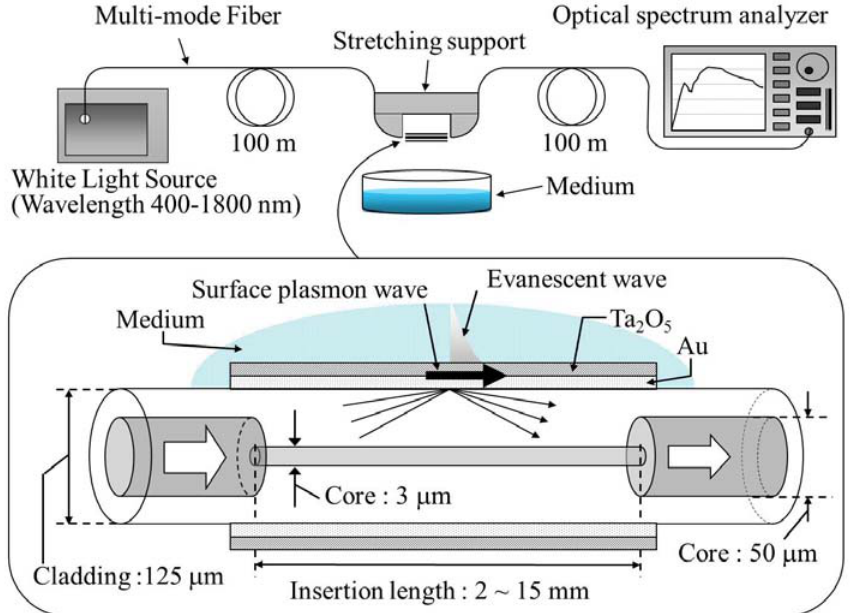
Figure 1. Hetero-core structured optical fiber SPR sensor and the experimental setup to measure the transmitted light